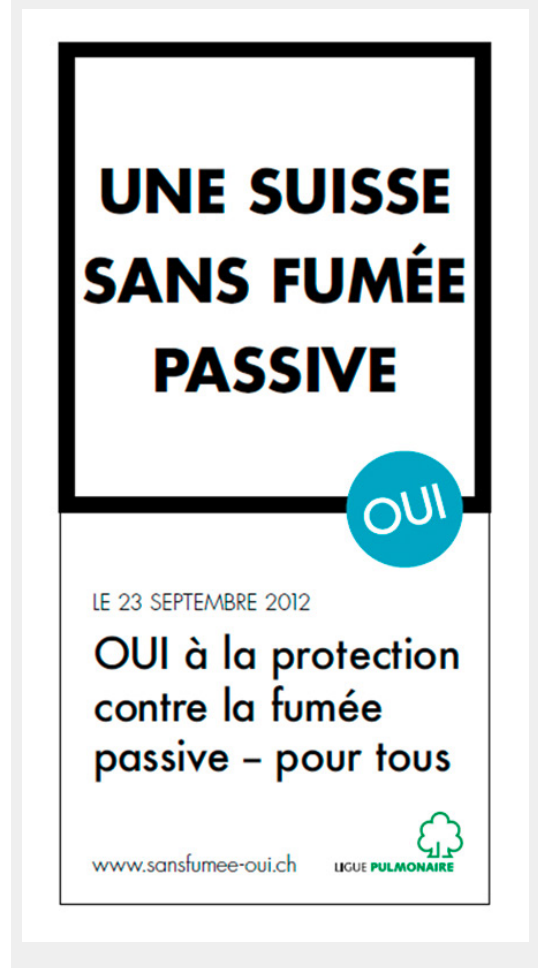
Figure 4 Sample advert in support of the